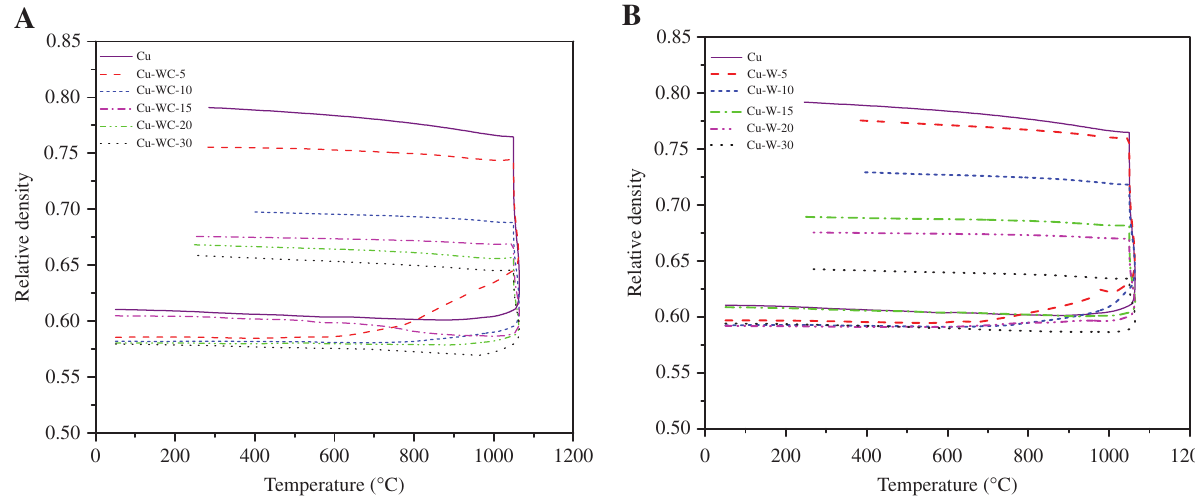
Figure 2: Relative density as a function of the temperature during the whole sintering cycle: (A) Cu-WC and (B) Cu-W.